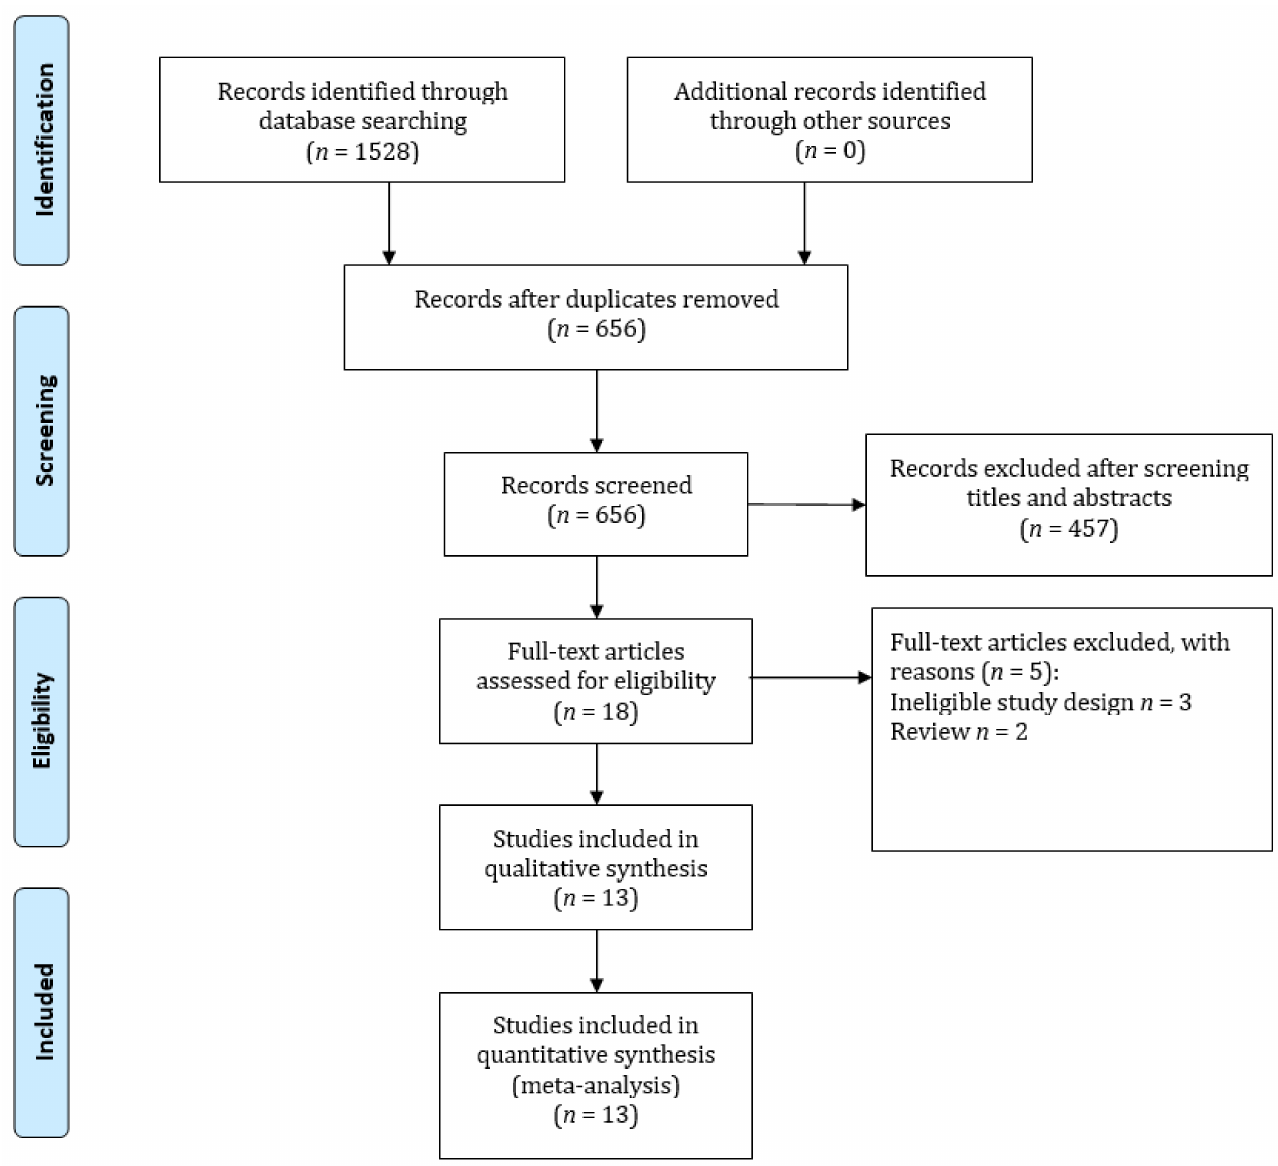
Figure 1. Flow diagram of the literature search and selection of the studies for the